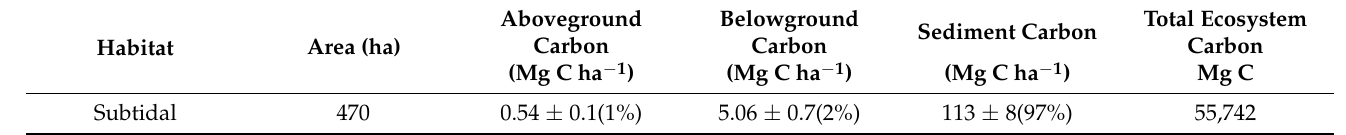
Table 6. Total carbon stocks in Subtidal seagrass meadows of Gazi Bay, Kenya.